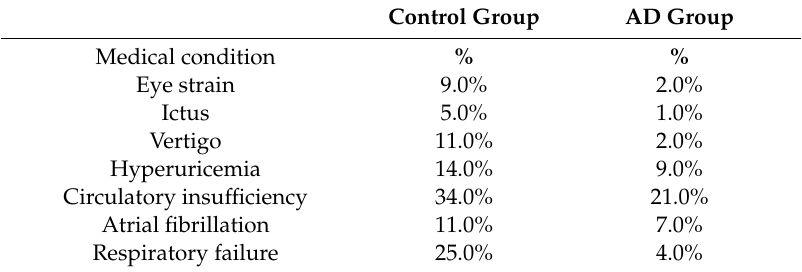
Table 3. Presence of comorbidities with lower incidence in the AD group.